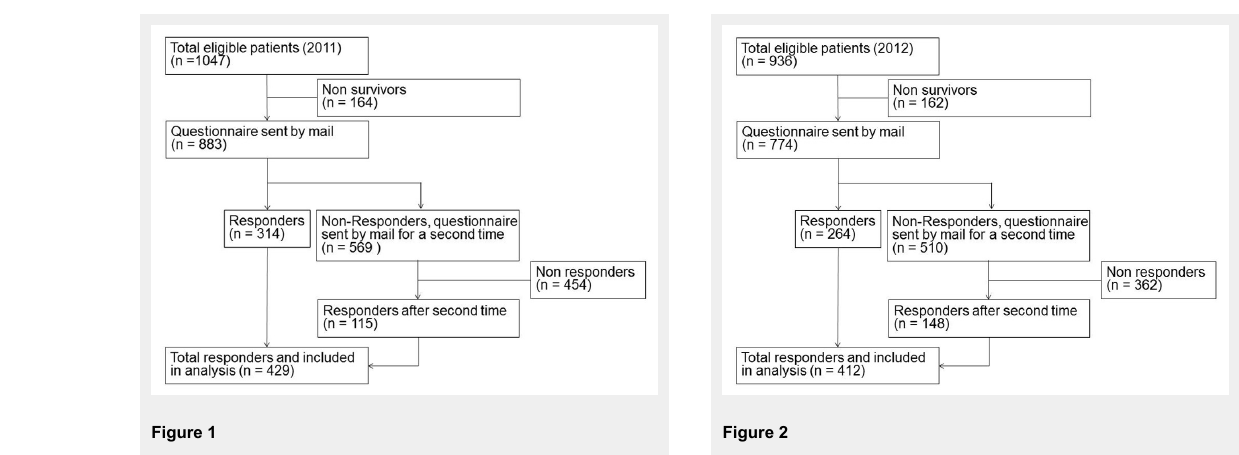
Patient inclusion flow chart 2011. Patient inclusion flow chart 2012.